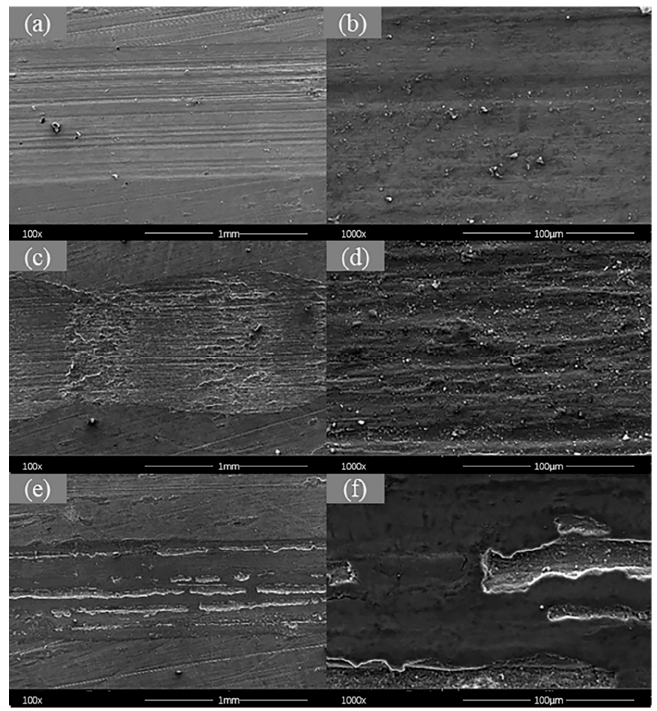
Figure 15. Wear morphology of alloying coating at different temperature: ( a , b ): 25 °C; ( c , d ): 350 °C; ( e , f ): 700 °C. coating surface to produce a normal stress and shear stress. At the same time, under the